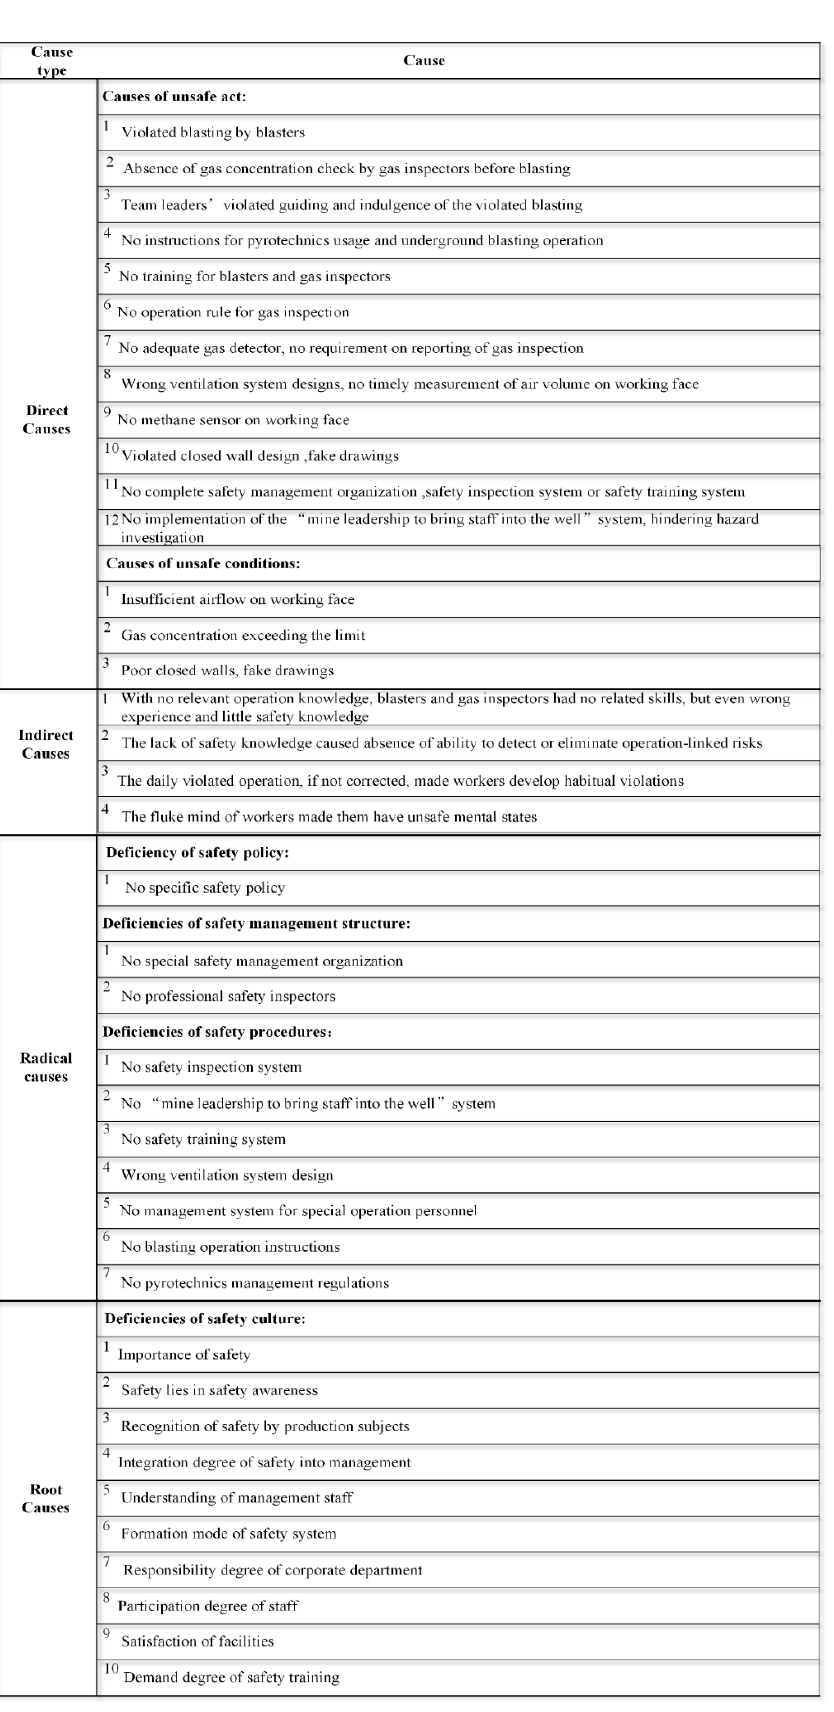
Figure 8. Accident analysis results based on 24Model.